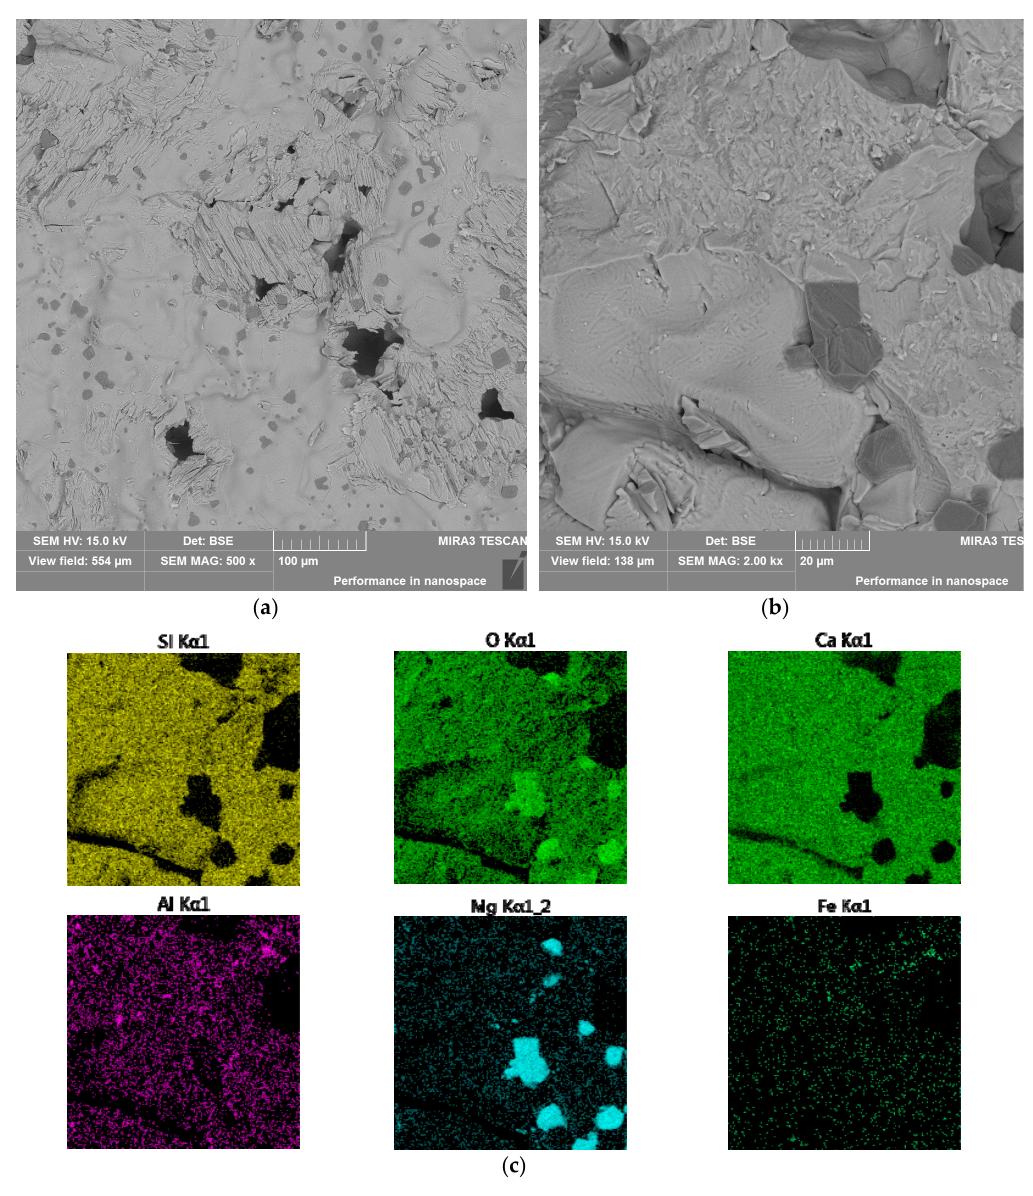
Figure 5. SEM images of the ACM sample after thermal treatment: surface; 500 × ( a ); fracture; 2000 × ( b ) and corresponding fracture EDS elemental maps ( c ).